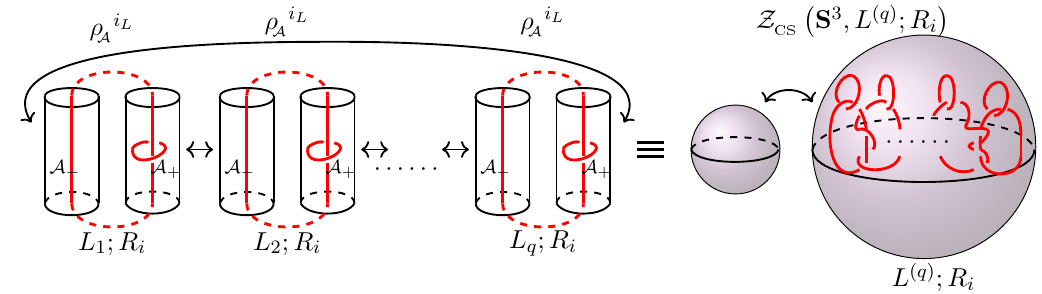
i L we need to A